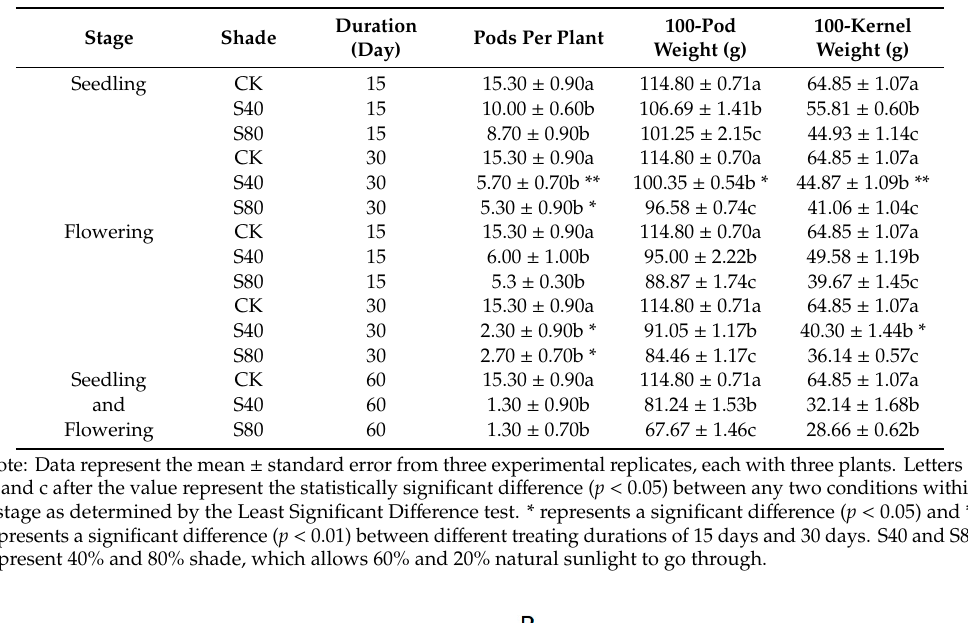
Table 2. E ff ects of shade stress on peanut yield components.